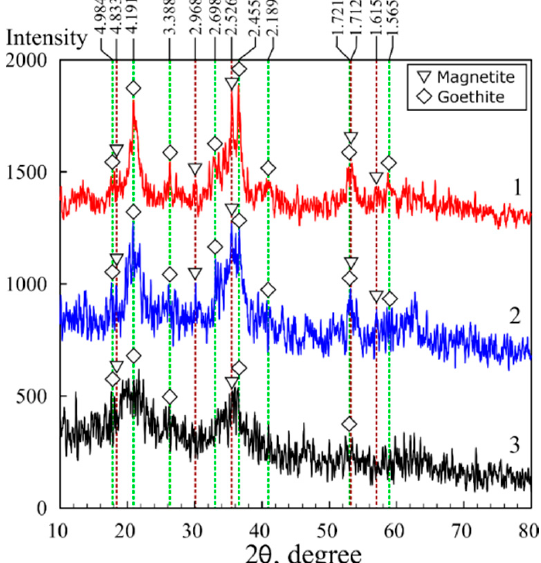
Figure 2. X-ray diffraction patterns of the magnetic composites based on chitosan: 1—sorbent 3M, 2—sorbent 3M-2, 3—sorbent 3M-4.